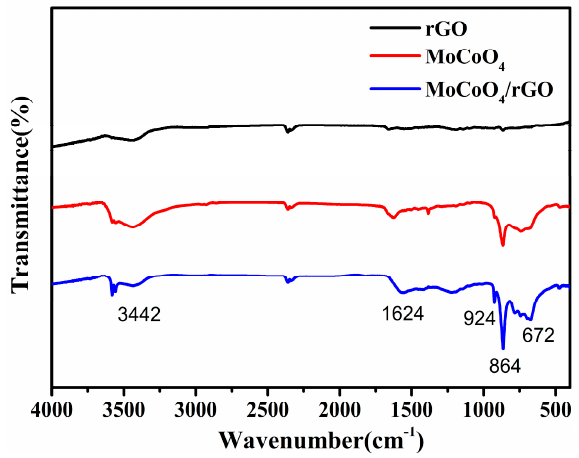
Figure 3 . FTIR spectra of the CoMoO 4 , rGO, and CoMoO 4 /rGO. Figure 3. FTIR spectra of the CoMoO 4 , rGO, and CoMoO 4